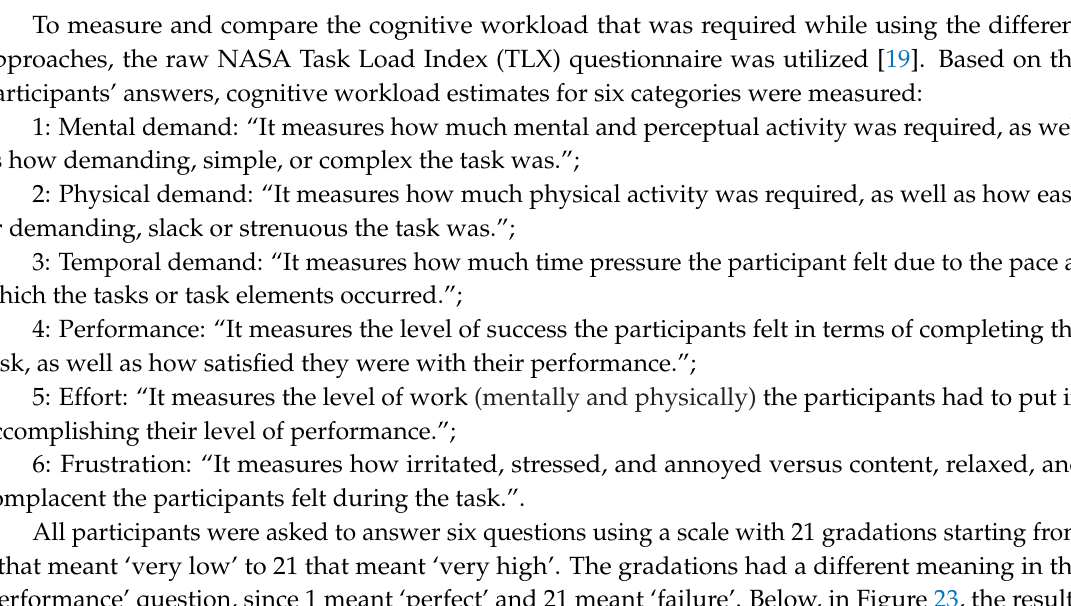
Figure 22. User experience results per category (attractiveness, perspicuity, efficiency, dependability, stimulation, and novelty) and per condition, in comparison with a benchmark dataset.